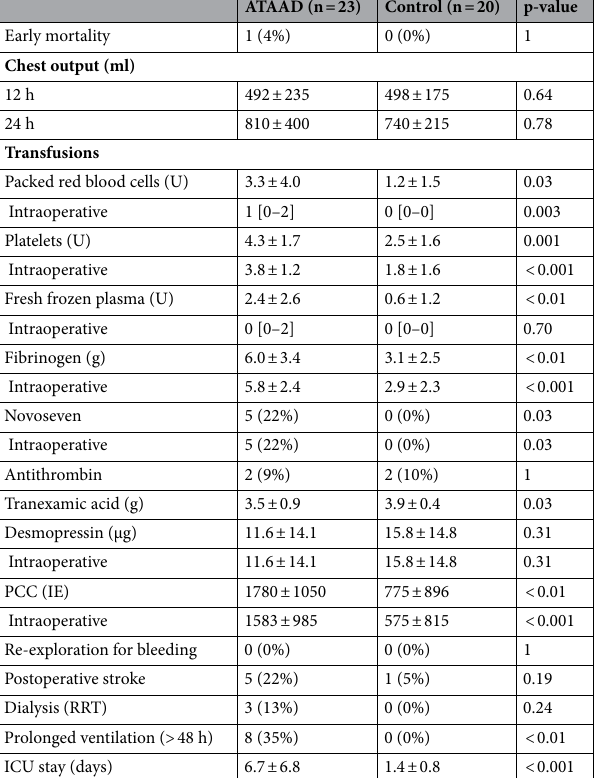
Table 3. Transfusion and postoperative characteristics. Values are expressed as numbers (%) or mean ± SD. ATAAD acute aortic dissection, PCC prothrombin complex concentrate, RRT continuous renal replacement therapy, ICU intensive care